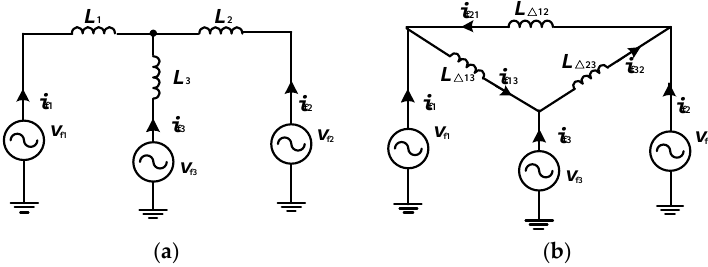
. For ease of analysis and design, we can set φ vector diagram of isolation control is shown in Figure 6, and is based on Equation (1).